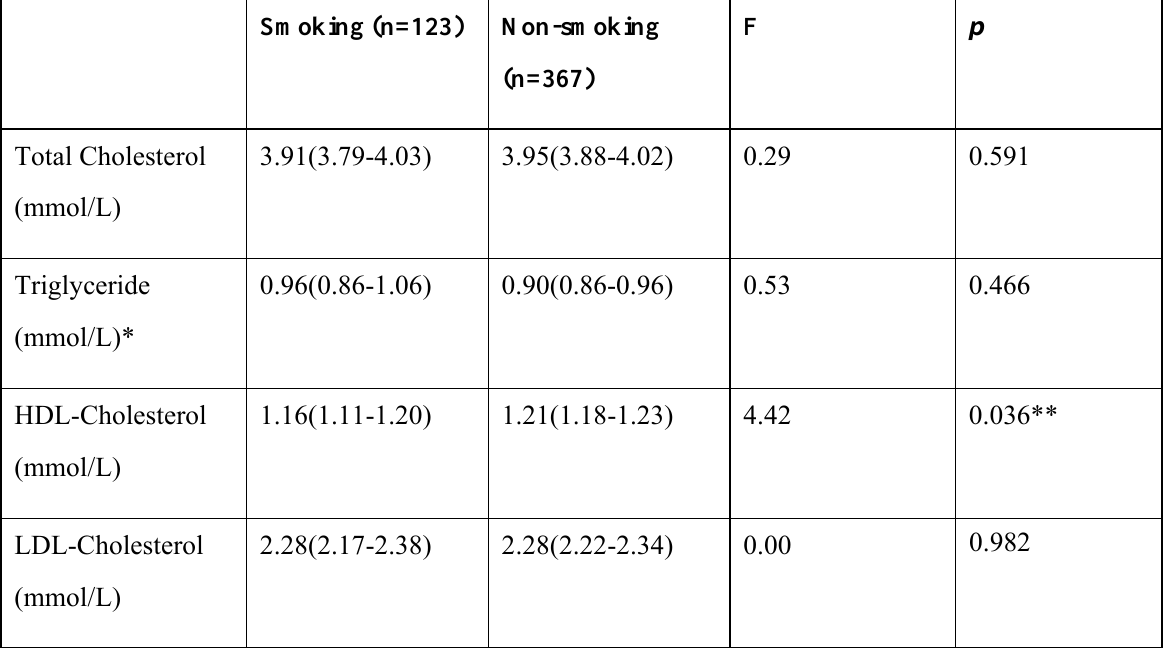
Table 3: Analysis of covariance assessing the effects of smoking using lipids as dependent variables, smoking as fixed factors, and age, BMI as covariates.